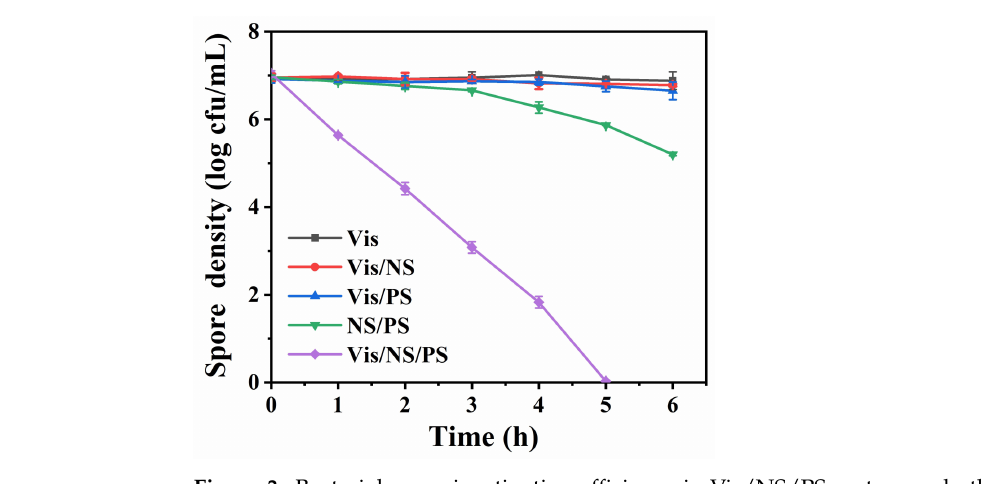
Figure 3. Bacterial spore inactivation efficiency in Vis/NS/PS system and other control systems including Vis, Vis/NS, Vis/PS and NS/PS. Table 1. Comparison with recent literatures on photocatalytic inactivation of bacterial